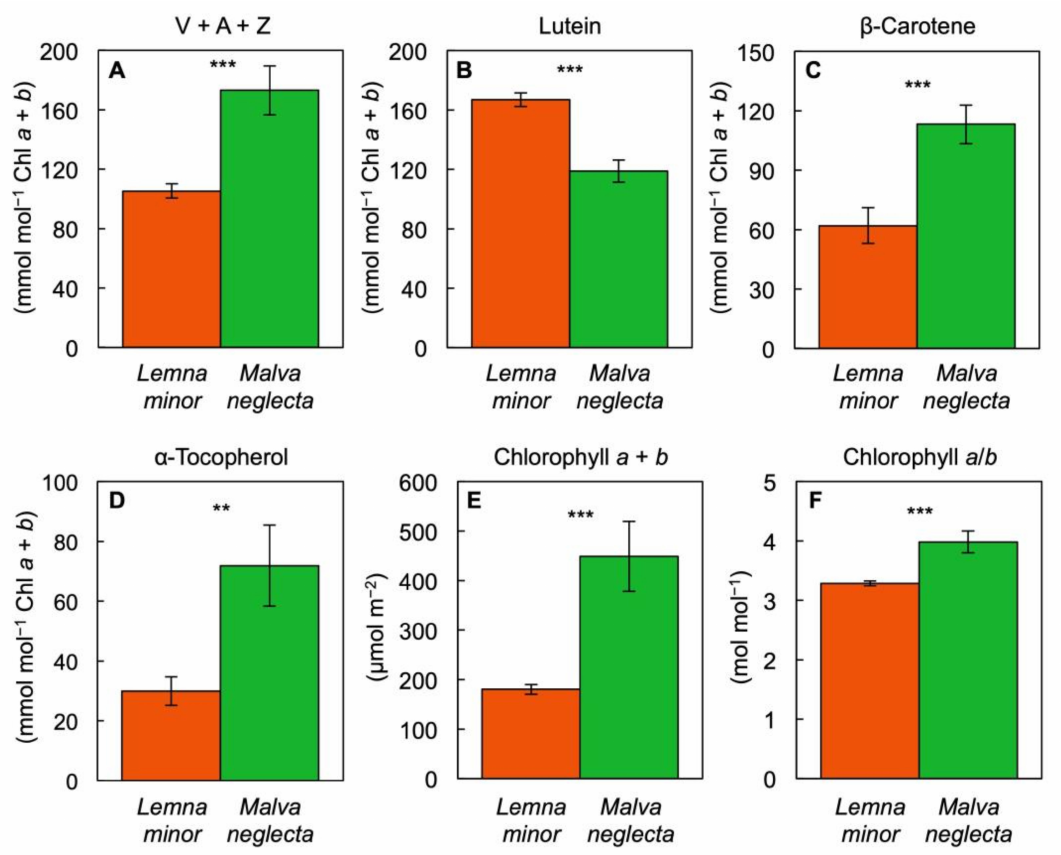
Figure 9. Levels of ( A ) the xanthophyll cycle pool constituents, violaxanthin, antheraxanthin, and zeaxanthin (V + A + Z), ( B ) lutein, ( C ) β -carotene, and ( D ) α -tocopherol per chlorophyll (Chl) a + b , ( E ) chlorophyll a + b levels per frond/leaf area, and ( F ) the molar ratio of chlorophylls a to b in fronds of Lemna minor (orange) and leaves of Malva neglecta (green) growing naturally in Superior, Colorado, USA. Mean values ± standard deviations; n = 4. Significant differences are denoted by asterisks; ** = p < 0.01, *** = p <